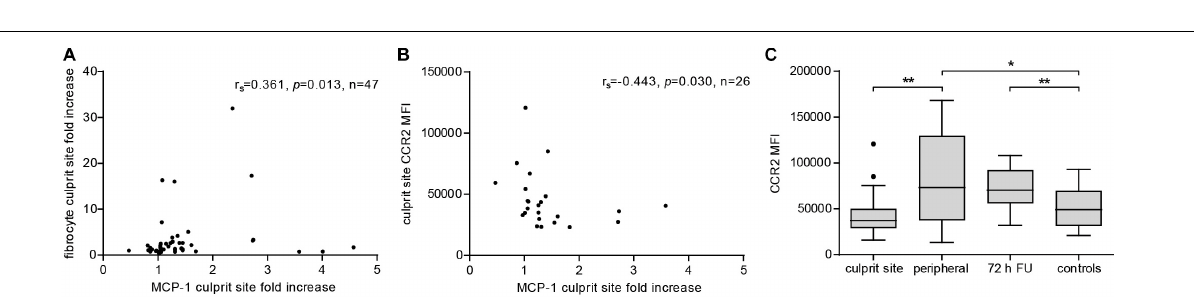
FIGURE 4 | Effect of MCP-1 on accumulation of fibrocytes and fibrocyte CCR2 expression at the culprit site. Fibrocyte counts in culprit and peripheral site blood, presented as influx ratio at the culprit site, and mean fluorescence intensity (MFI) of CCR2 expression were determined by flow cytometry; MCP-1 was measured by ELISA and presented as fold increase at the culprit site. (A) Correlation of relative fibrocyte count at the culprit site with MCP-1 fold increase (Spearman signed-rank test, r s = 0.361, n = 47). (B) Correlation of fibrocyte CCR2 expression at the culprit site with MCP-1 fold increase (Spearman signed-rank test, r s = –0.443, n = 26). (C) CCR2 receptor expression on fibrocytes of culprit site ( n = 26), peripheral site ( n = 26), 72 h follow-up ( n = 14), and healthy control blood ( n = 18). Statistical tests for respective pairwise comparisons, and corrected and uncorrected p values are provided in Supplementary Table S2 . Data are presented as boxplots with whiskers defined according to Tukey. * p < 0.05, ** p < 0.01.